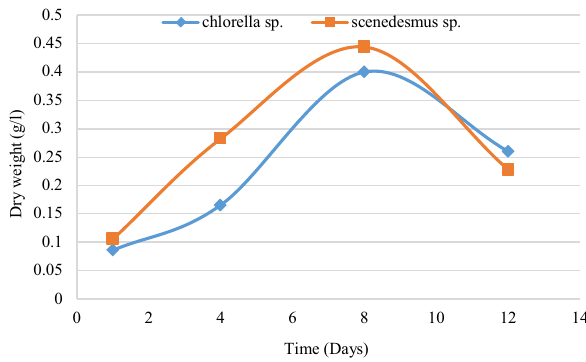
Fig. 1 Growth (CC) curves of isolated microalgae in a wastewater sample